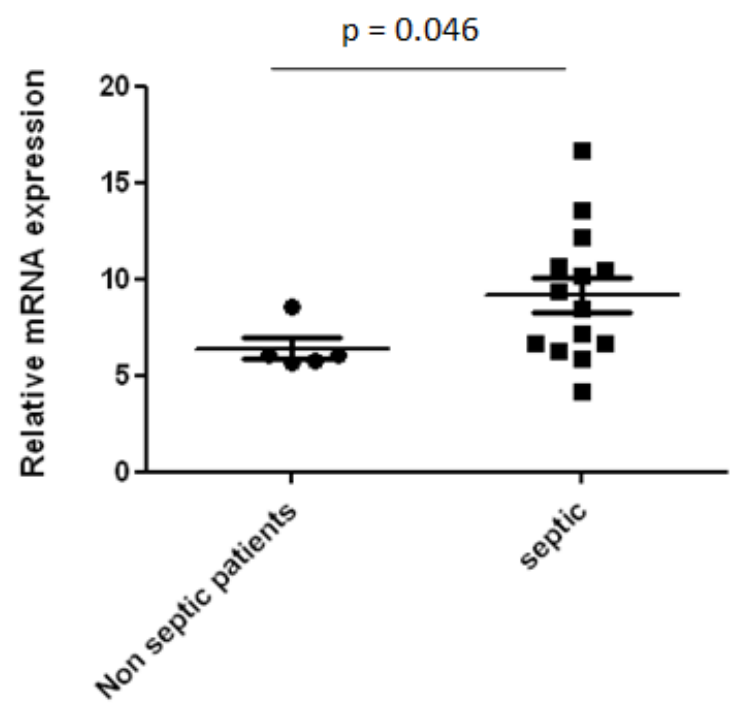
Figure 3. IL-18 mRNA expression in the serum of septic and non-septic